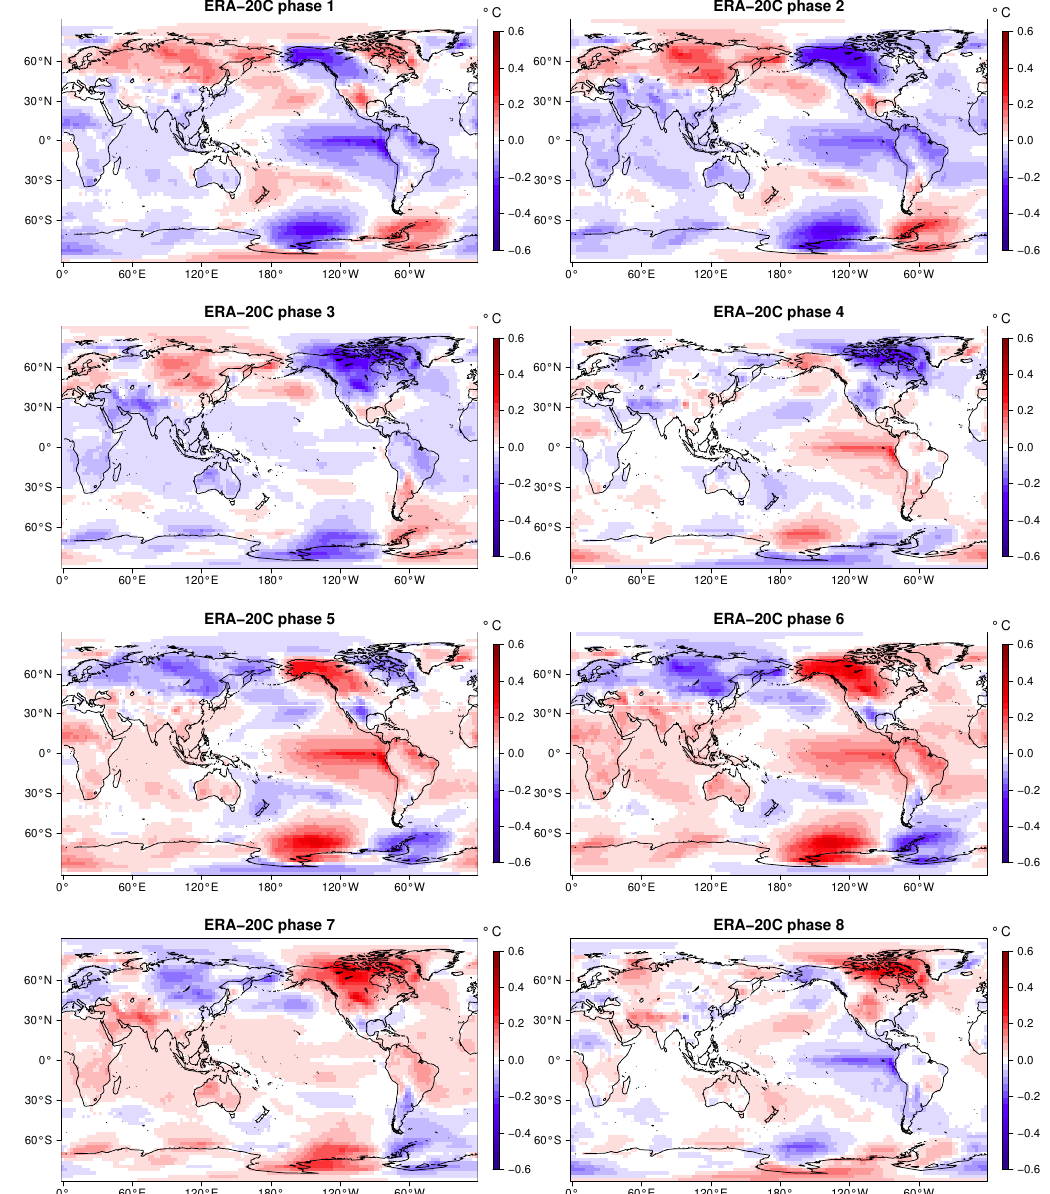
Figure 6. ERA-20C phase (1–8) composites of the 3–4 year variability mode. Unit ◦